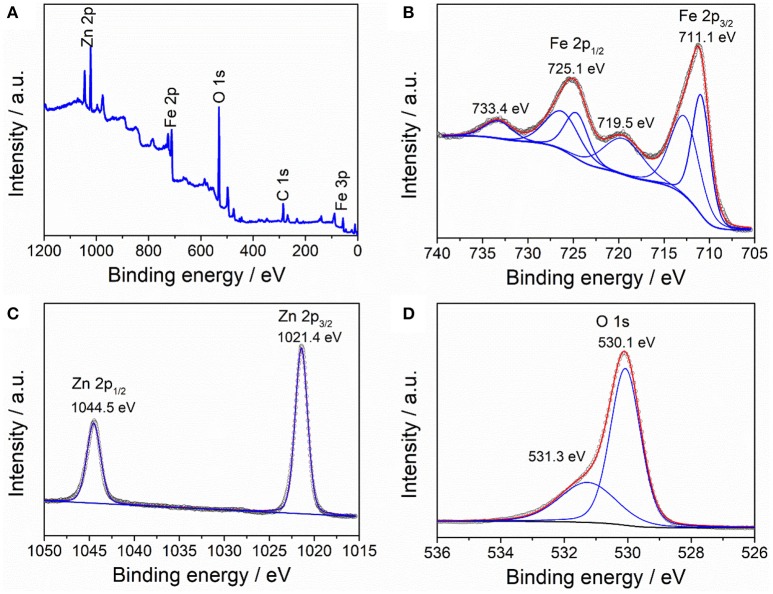
XPS spectra of ZnFe2O4/α-Fe2O3 nanocomposites: (A) survey of the sample, (B) Fe 2p, (C) Zn 2p, and (D) O 1s.